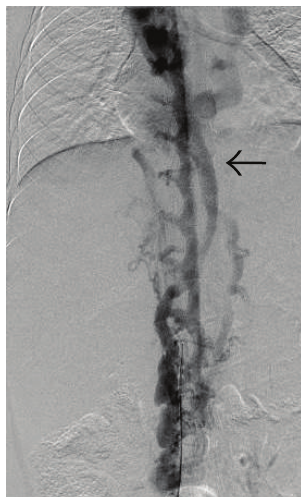
Figure 31: IVC angiogram demonstrating opacification of the intervertebral venous plexus and hemiazygous vein